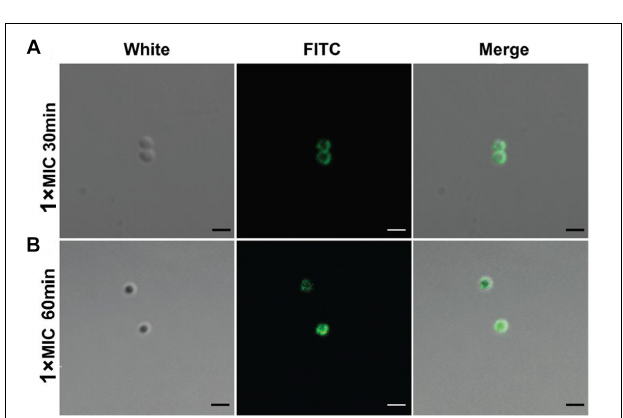
FIGURE 2 | Confocal microscopic imaging shows DP7 aggregation on the cell surface and entry into cells. Confocal microscopic images of S. aureus ATCC 25923 after treatment with FITC-DP7 at 1 × MIC for (A) 30 and (B) 60 min. The increasing fluorescence intensity from 30 to 60 min after treatment with the DP7 peptide may indicate progressive membrane damage and pore formation in S. aureus ATCC 25923, allowing increased uptake of the fluorescent probe. The scale bar in this figure is 1 µ